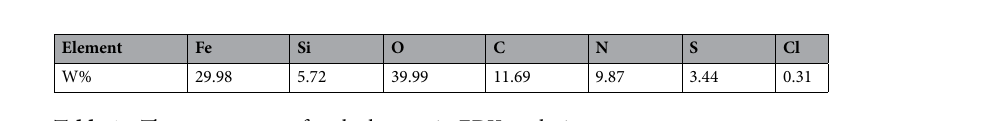
Table 1. The percentages of each element in EDX